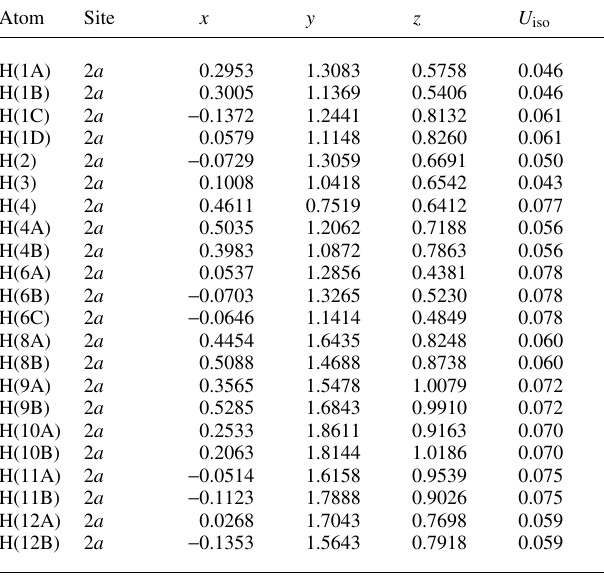
Table 2. Atomic coordinates and displacement parameters (in Å 2 )